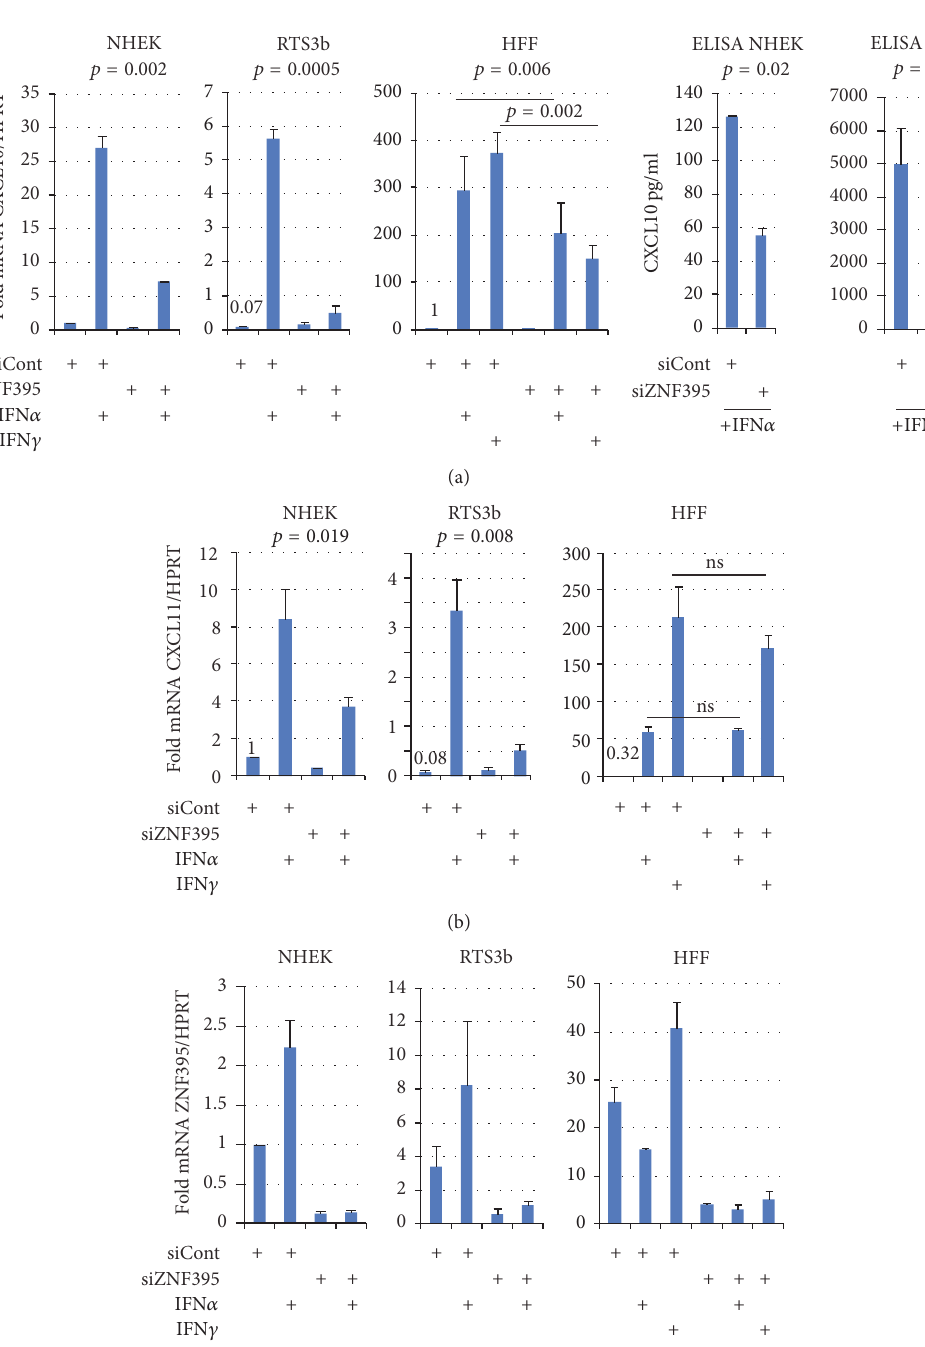
Figure 3: ZNF395 modulates the expression of CXCL10 and CXCL11. Primary human epithelial keratinocytes (NHEK), RTS3b cells, and primary human foreskin fibroblasts (HFF) were transfected with siRNA against ZNF395 or control siRNA and treated with IFN 𝛼 or IFN 𝛾 , as indicated. (a) QRT-PCR was performed with primers to amplify CXCL10 and HPRT. The fold changes after normalization for the expression of HPRT were calculated and adjusted to the value of nontreated NHEK transfected with control siRNA, which was defined as 1. The result of ELISA-assays with the supernatant of NHEK and HFF to determine the concentrations of CXCL10 is shown on the right. (b) CXCL11 expression analyzed by qRT-PCR with RNA from siRNA transfected NHEK, RTS3b, and HFF treated with either IFN 𝛼 or 𝛾 . (c) The relative expression level of ZNF395 in siControl transfected NHEK was set as 1 and the fold changes of all other cell types have been calculated. The diagrams show the means of three independent experiments. Standard deviations are